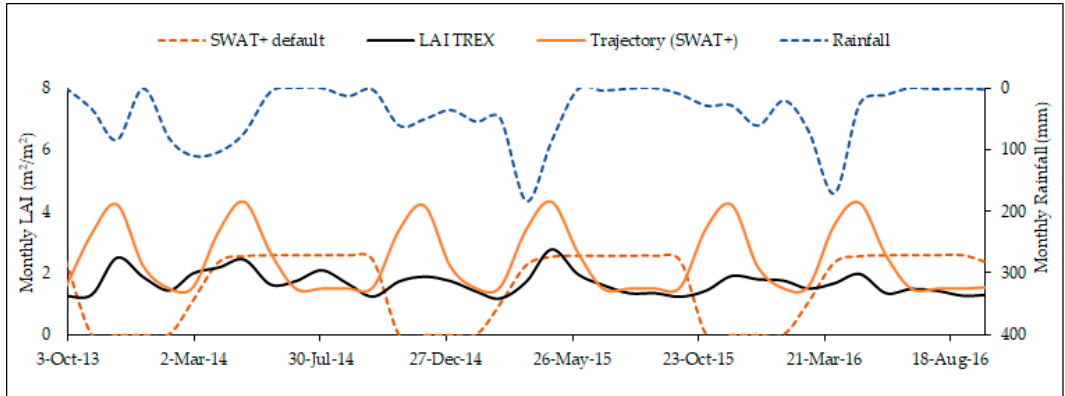
Figure 7. LAI comparison of the irrigated banana, coffee, and maize land use, default and trajectory implementation in SWAT+.